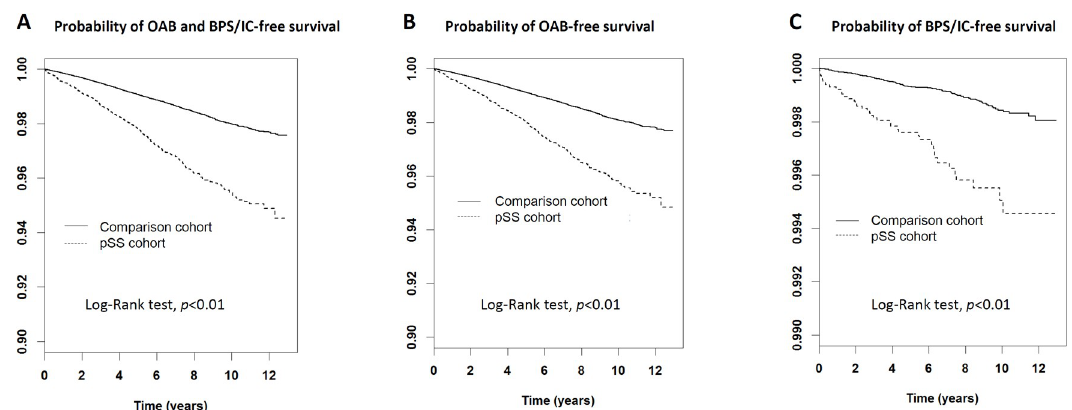
Fig 2. Comparisons of probabilities of (A) OAB and BPS/IC-free, (B) OAB-free, (C) BPS/IC-free survival between pSS and comparison cohorts. pSS: Primary Sjo¨gren syndrome; OAB: overactive bladder; BPS: bladder pain syndrome; IC: interstitial cystitis.